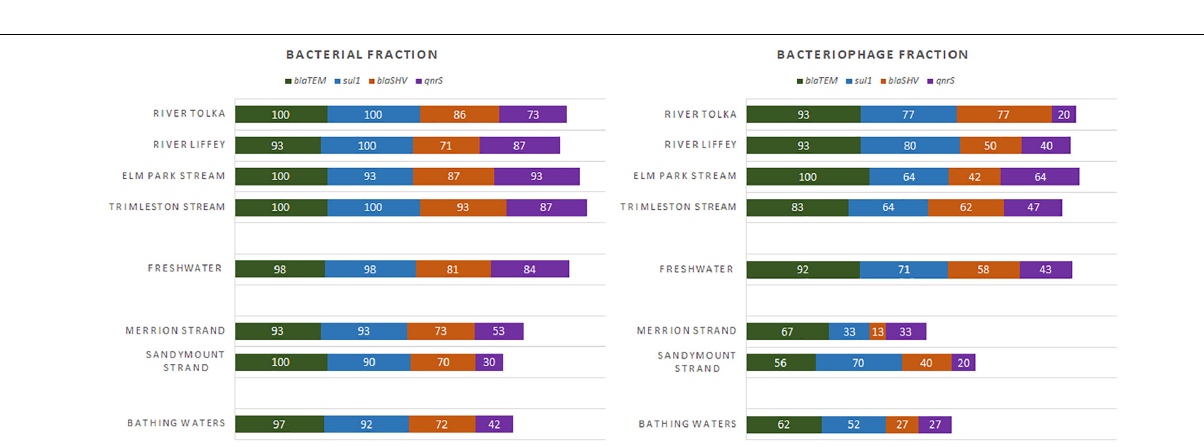
Frontiers in Microbiology |